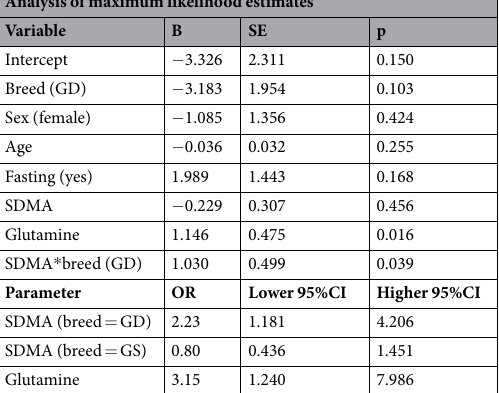
skeletal muscle. In turn, the tissues with highest glutamine metabolism are kidney, intestine, immune system and liver 34,35 . Glutamine actions in the brain are mostly mediated by degradation of glutamine to glutamate as a part of glutamate-glutamine cycle 30 . The role of glutamate-glutamine cycle is to maintain normal extracellular glutamate levels in the brain and to remove excess ammonia, formed as a byproduct in the glutamate-glutamine cycle, into circulation 36 . Correct activity and function of this cycle is essential for proper glutaminergic neurotransmission since glutamate is the most abundant and primary excitatory neurotransmitter in the CNS 37 . Indeed, disturbed glutaminergic neurotransmission has been suggested to be involved in a wide spectrum of neuropsychiatric